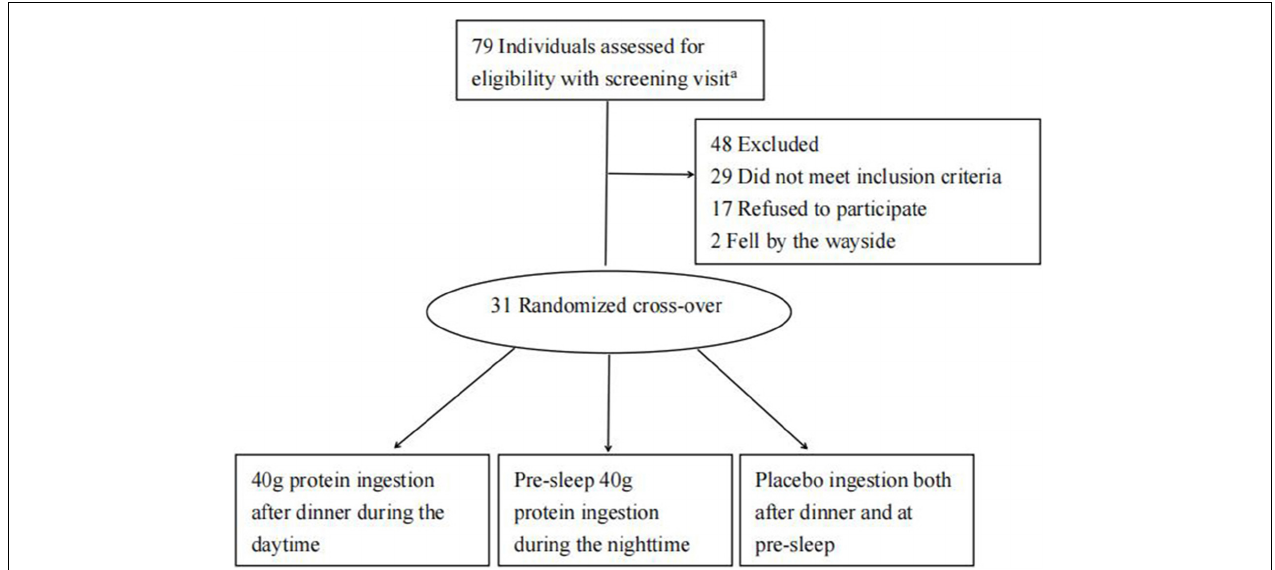
FIGURE 1 | Participant inclusion flowchart. a There were 201 people who contact us by network in response to the E-recruitment poster, but only 79 were considered appropriate for further standard